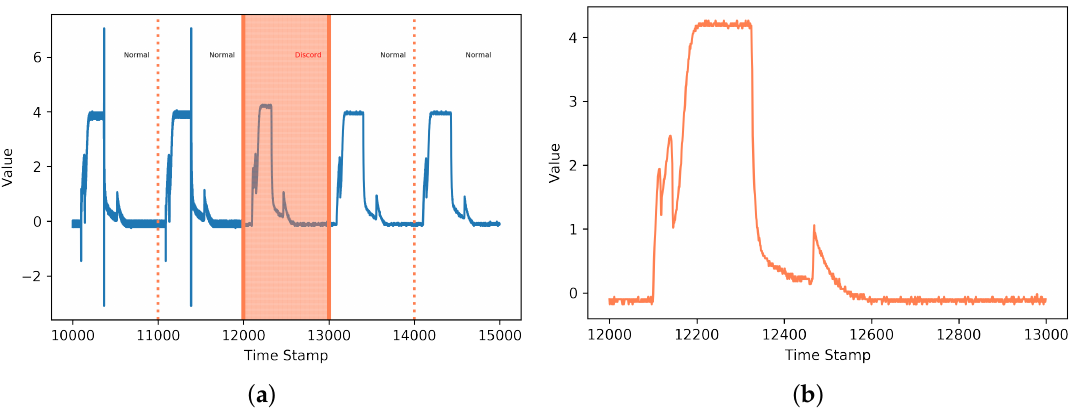
Figure 8. Detection results of the proposed methods.As shown in ( a ), subsequence labeled in orange color refers to a discord, shaded in orange denotes detections made by the proposed. The discord sequence detected by HM-AL-CNN is shown specifically in ( b